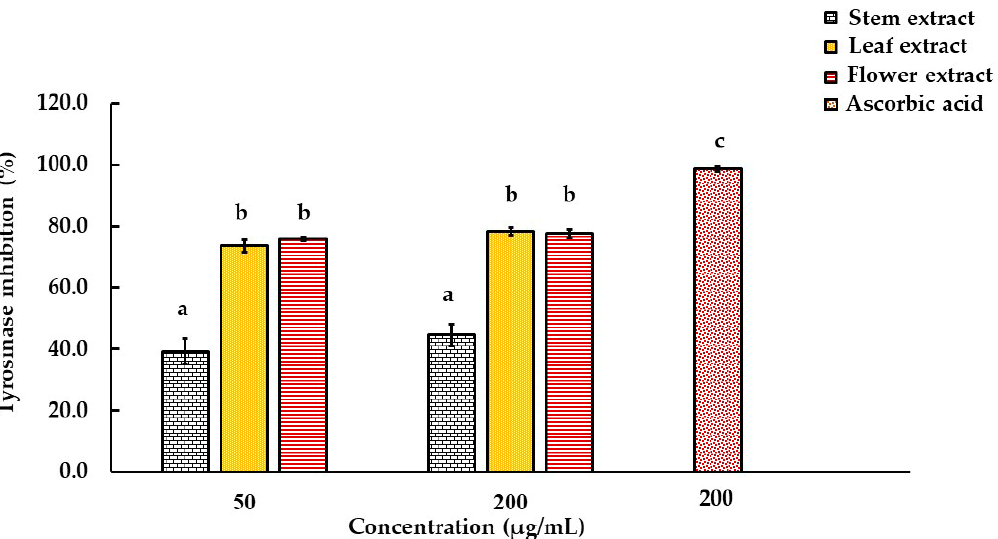
Figure 6. Effect of ethanolic extract of D. sulcatum stems, leaves and flowers (50 and 200 µg/mL) on